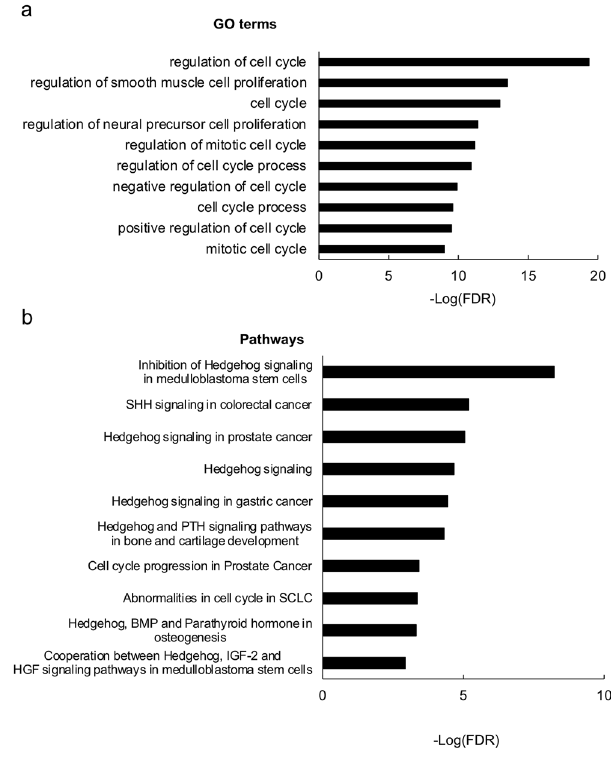
Fig. 2 GO terms and biological pathways related to cell cycle or hedgehog signaling that are enriched among TR-bound genes in intestine. a Top 10 enriched GO terms related to cell cycle. The GO terms that were enriched among genes bound by TR in the wild-type intestine were ranked based on FDR as shown in Supplementary Data 5. The most signi fi cant GO terms related to cell cycle were plotted here (see Supplementary Data 18 for raw data). b Top 10 enriched pathways related to cell cycle or hedgehog signaling. The biological pathways that were enriched among genes bound by TR in the wild-type intestine were ranked based on FDR as shown in Supplementary Data 6. The most signi fi cant pathways related to cell cycle or hedgehog signaling were plotted here (see Supplementary Data 19 for raw